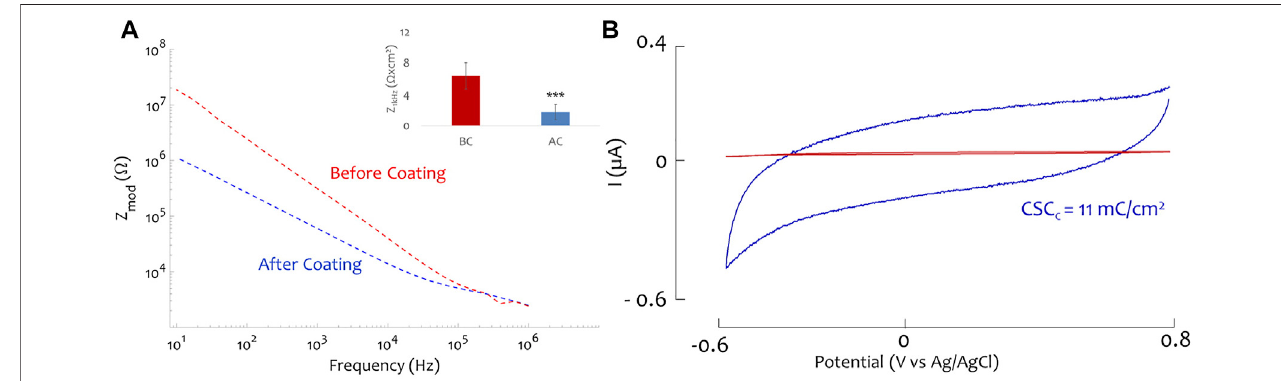
FIGURE 2 | PtIr coated carbon fi ber. (A) Electrochemical impedance spectroscopy (EIS) measurement of one sharpened carbon fi ber before and after the plating process;asinsetthemeanandstandarddeviationofthenormalizedimpedanceisreportedbefore(red)andafter(blue)thecoating,***indicatea p -value (cid:1) 1.02 × 10 − 18 . (B) Cyclic voltammetry (CV) of a sharpened carbon fi ber before (red) and after (blue) the PtIr plating process, the cathodic charge storage capacity of the electrode increases to 11 mC/cm 2 after the coating (0.2 mC/cm 2 before the coating).